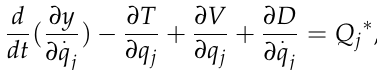
Figure 1. Power train shell crack. ( a ) Before cracking; ( b ) after cracking.